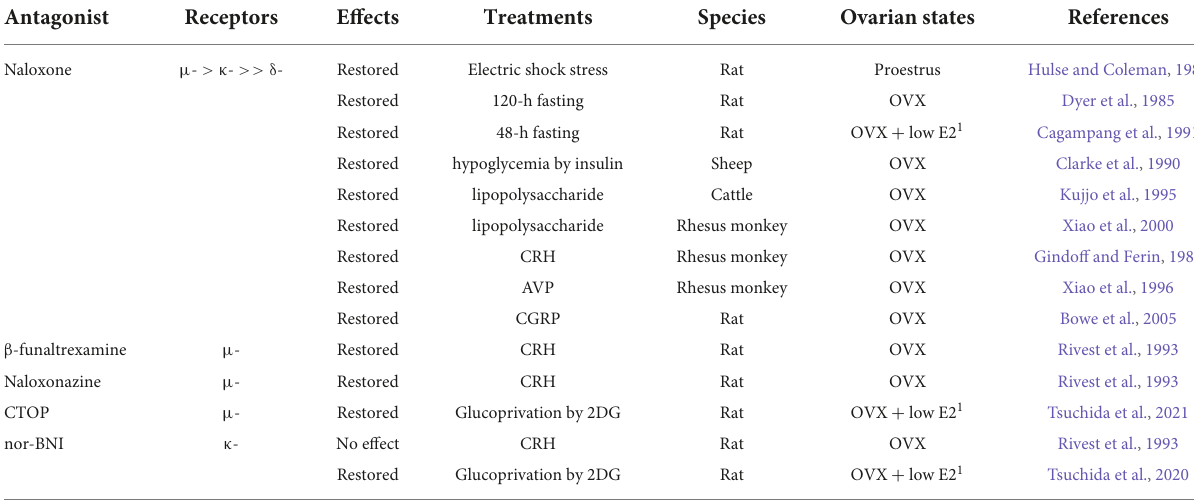
TABLE 4 Effects of opioid receptor antagonists on tonic luteinizing hormone (LH) secretion in female mammals under stressful